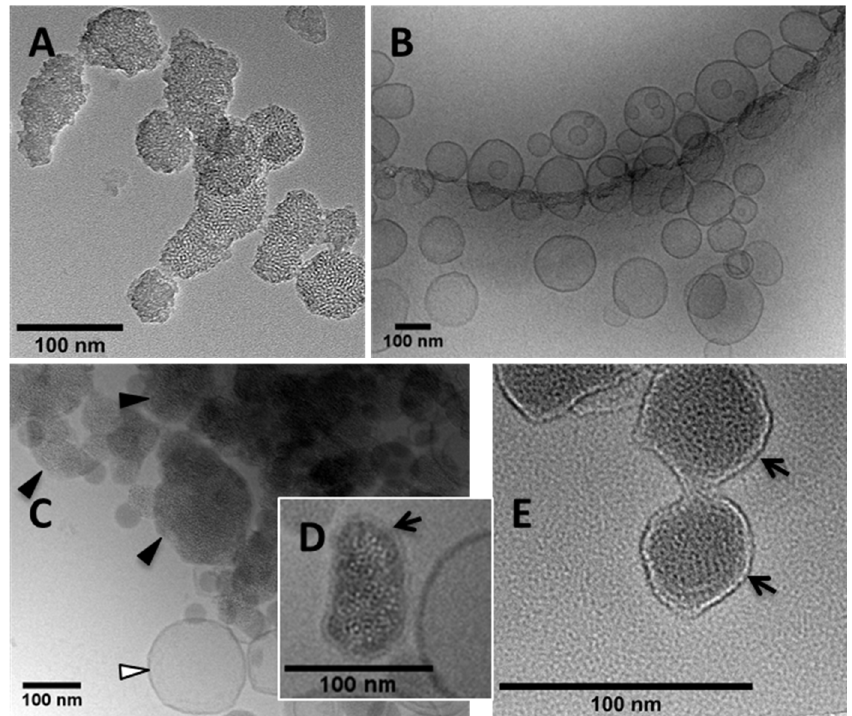
Figure 3. TEM micrographs of various formulations. ( A ) MSNPs showing mesoporous structure. ( B ) CryoTEM micrograph of cationic liposomes. ( C , D ) CryoTEM micrograph of lipid coated MSNPs. ( C ) Black triangles pointing to the mesoporous structure of lipid coated MSNPs, and white triangles pointing to liposome. ( D ) Black arrow indicates a membrane-like structure around lipid coated MSNPs. ( E ) Negatively stained lipid coated MSNPs. Black arrow indicates a membrane-like structure around lipid coated MSNPs.